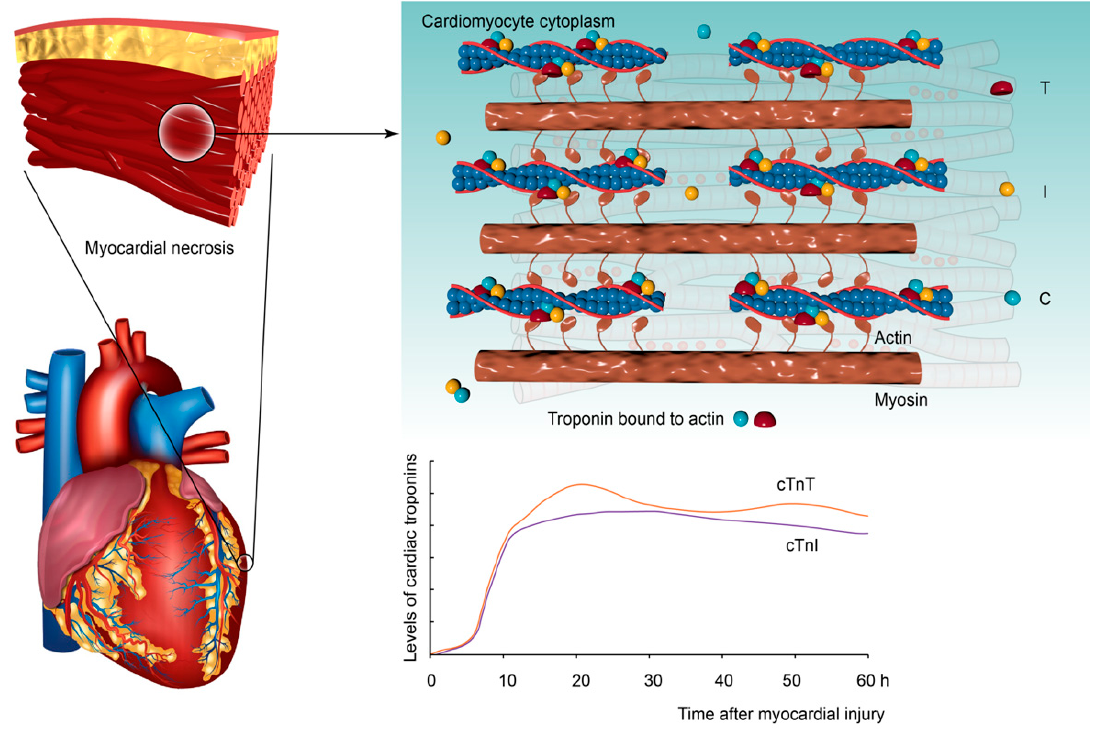
Figure 1. Schematic diagram of cardiac troponin composition.